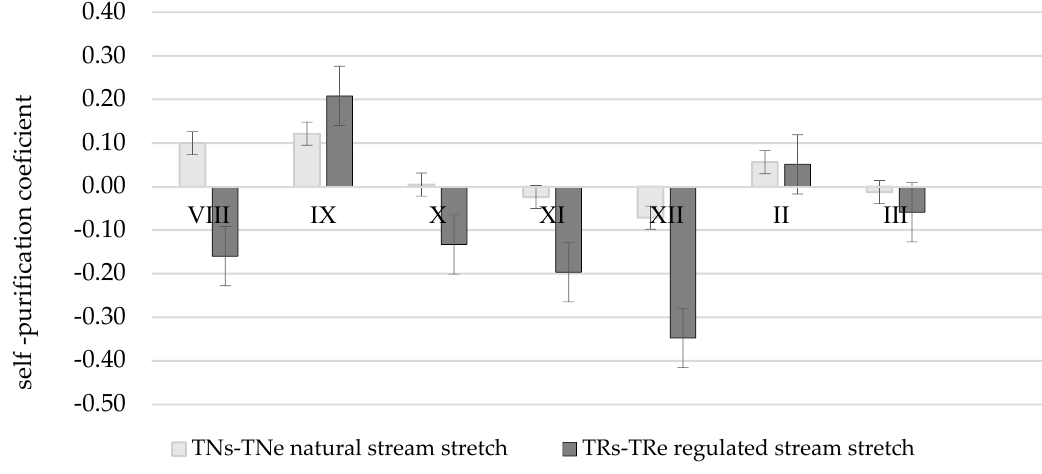
Figure 9. Nitrate ( NO − 3 ) self-purification coefficient in Terpin ė stream.